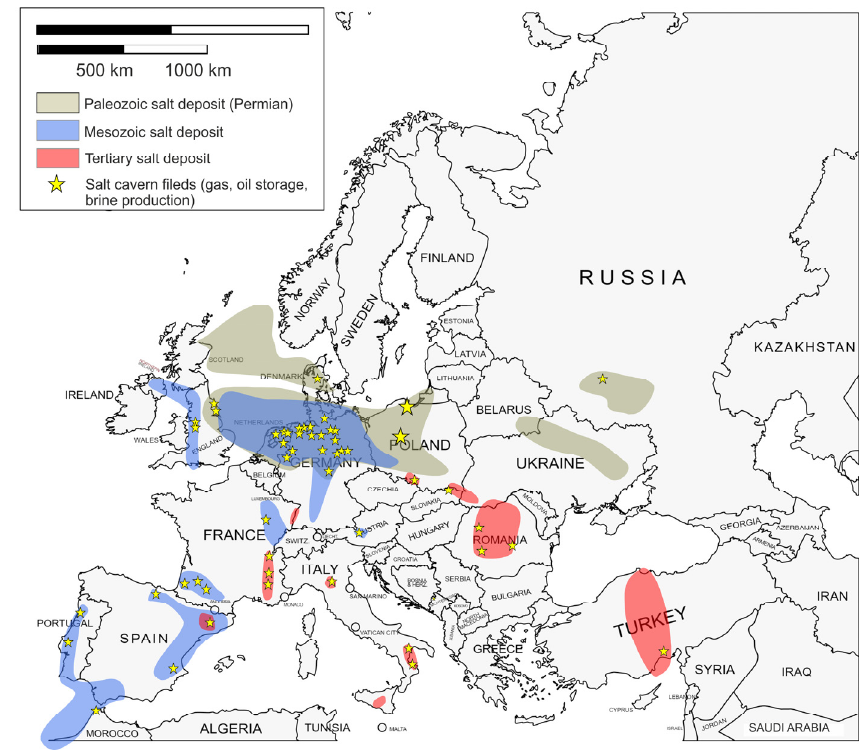
Figure 4. Salt deposits, brine production and salt cavern storage sites across Europe.